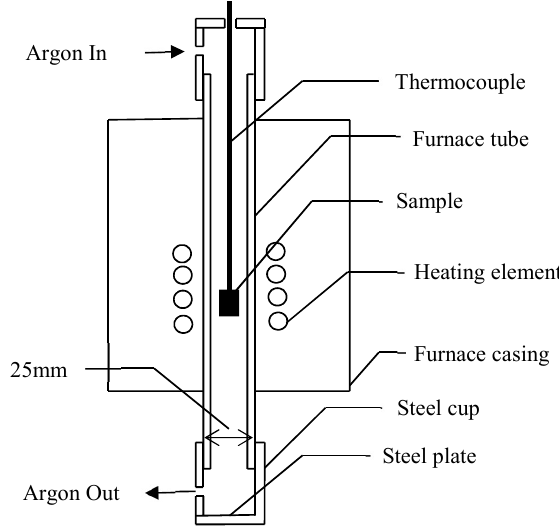
Figure 3. Schematic drawing of the furnace set-up.